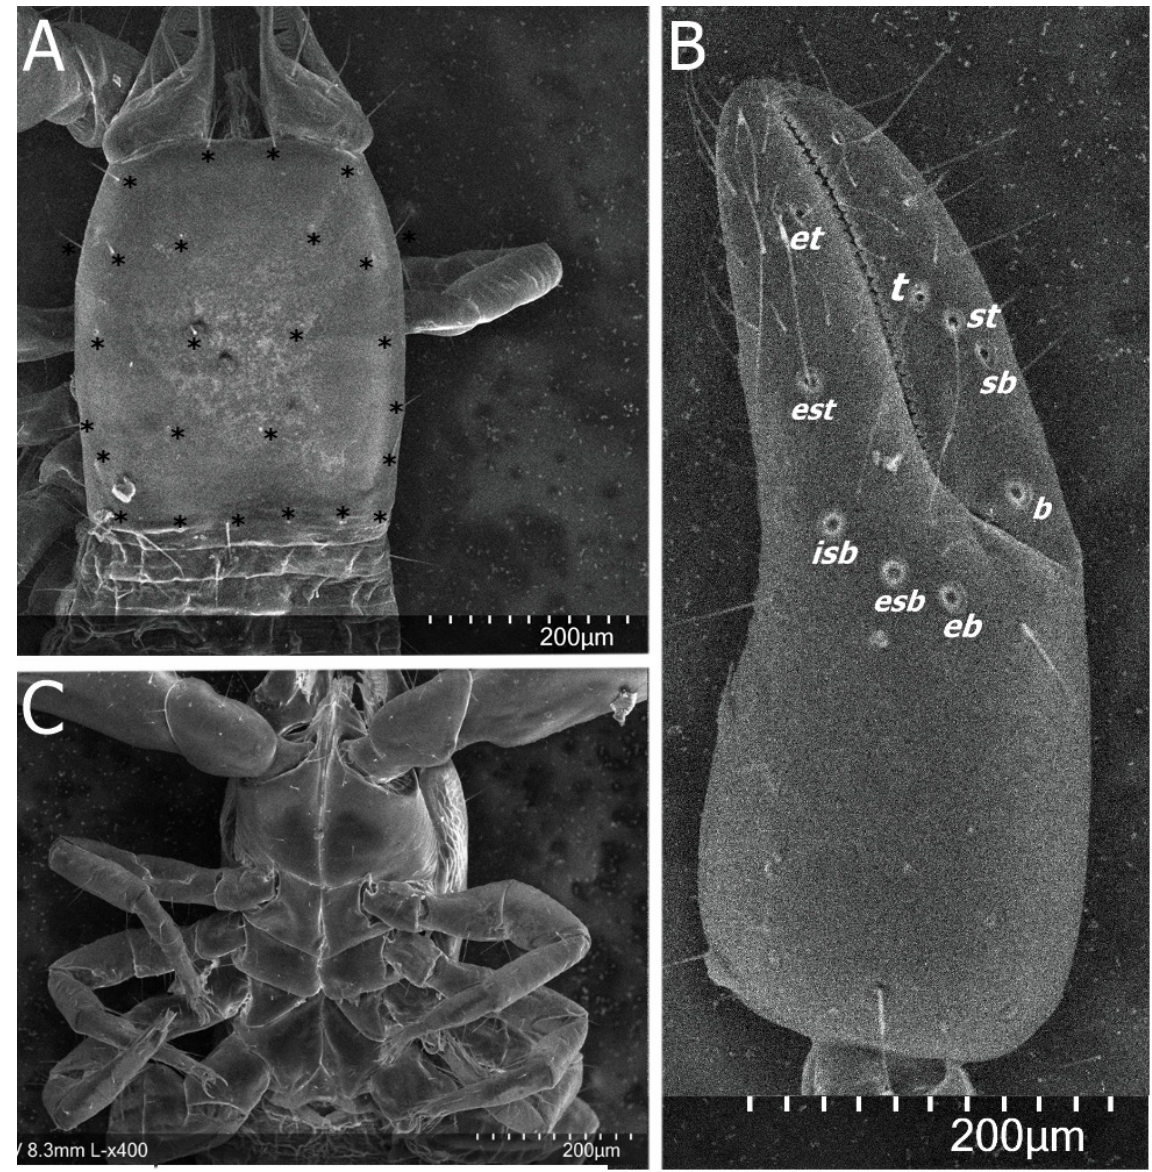
Fig. 21. Scanning electron micrographs of Ideoblothrus nadineae sp. nov., paratype, ♂ (ZMH A0003695). A . Carapace with asterisks next to setae. B . Chela in retrolateral view, showing trichobothria. C .